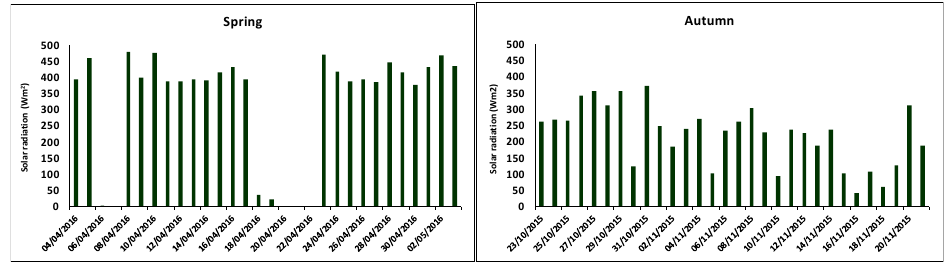
(LeafL) Measured on the terminal leaflet of third trifoliate leaf from pulvinus to leaf tip (cm) Width of the central sheet *** (Wcshe) Measured on the terminal leaflet of the third trifoliate leaf (cm) 6.1.1. Hypocotyl length (HypL) Average length in cm, from 5 plants. Measured when primary leaves were fully expanded 6.1.9. Plant height (PlantH) Average height, in cm, at maturity, from 5 plants. Measured from cotyledon scar to tip of the plant 6.1.10. Stem diameter (StemD) Measured in mm at maturity for plants at crop density Inflorescence and pod 4.2.2. Days to flowering (Dflow) Number of days from emergence to the stage where 50% of plants have set flowers 4.2.3. Flower buds (FlowBI) Average number of flower buds from 5 plants, examining one inflorescence from each plant Table 1. Quantitative and qualitative traits in the 24 Phaseolus vulgaris accessions. IBPGR— (PodL) Average length, in cm, of the largest fully expanded immature pod International Board for Plant Genetic Resources. 6.2.9. Inflorescence length (InfloL) Average length, in cm, from 5 plants 6.2.10. Pedicel length (PedL) Average length, in cm, of older flower from 5 plants, examining one inflorescence from each plant 6.2.18. Pods per plant (PPlant) Average from 5 plants at crop density Days to harvest *** (Dharv) Time period between seed sowing and mature pods sampling Seed 6.3.1. Seeds per pod (SeedP) Average number of seeds from one pod, selected from 5 plants 6.3.3. Seed weight (SeedWh) Weight of 100 seeds, in grams 6.3.5.1. Length (SeedL) Measured parallel to the hilum (mm) 6.3.5.2. Width